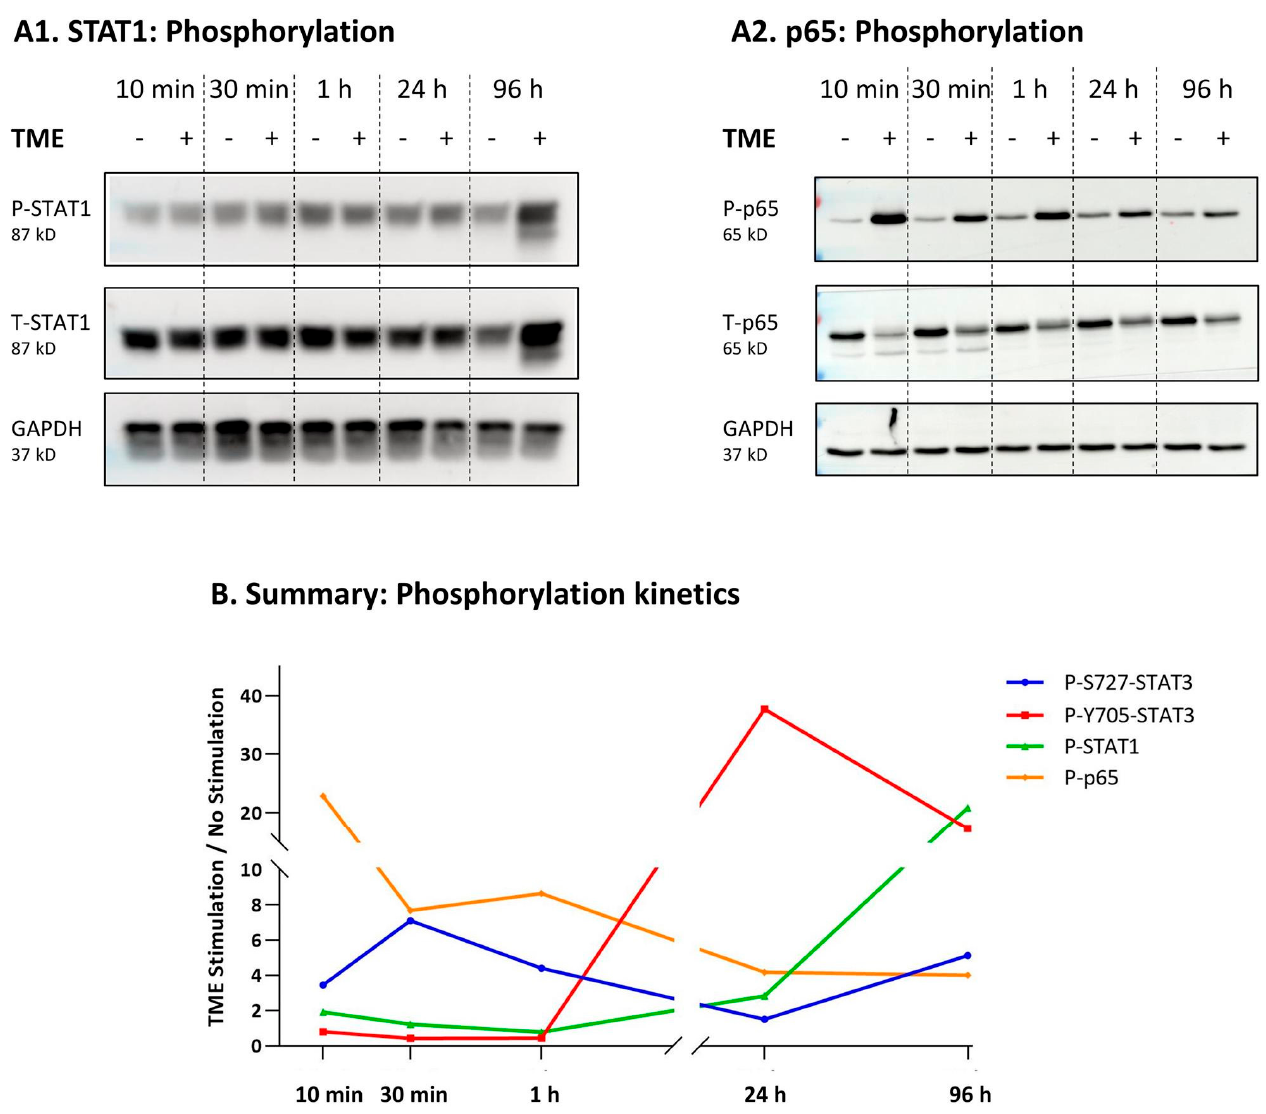
Figure 7. Upon TME Stimulation, STAT1 is activated in slow kinetics and p65 in rapid kinetics, in HR+/HER2 − breast cancer cells: MCF-7 cells were stimulated by TME Stimulation (TME; concentra- tions as described in Figure 1) or treated by a vehicle control (“No Stimulation”). ( A ) Phosphorylation kinetics of STAT1 ( A1 ) and p65 ( A2 ), determined by WB kinetics analyses. The results are from a representative experiment of n = 3, showing similar results. ( B ) Summary of the kinetics of phos- phorylation of S727-STAT3, Y705-STAT3 (representative experiments are shown in Figure 4), STAT1 and p65 (representative experiments are shown above in Figure 7A). The data in this part show the averages of n = 3 experiments for each phosphorylated protein, demonstrating fold change between TME-stimulated and non-stimulated cells. The uncropped blots are shown in Figure